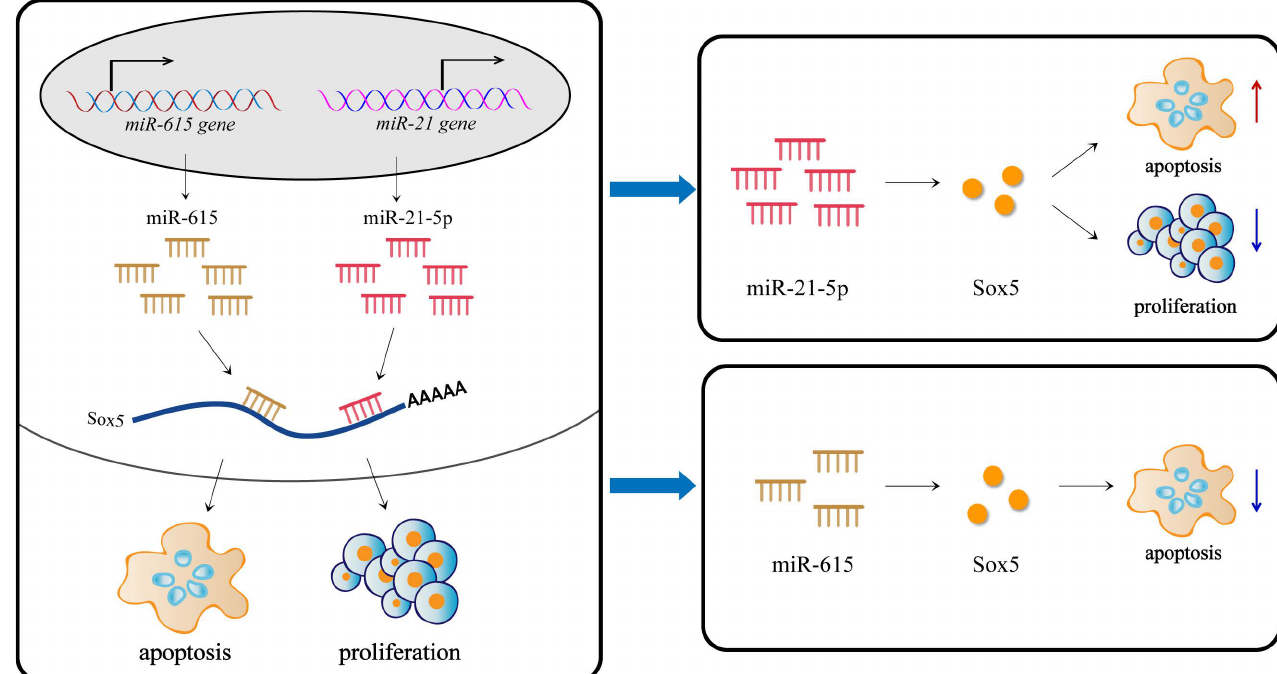
Figure 5. Proposed model of ssc-miR-21-5p and ssc-miR-615 regulation on Leydig cells proliferation and apoptosis by targeting